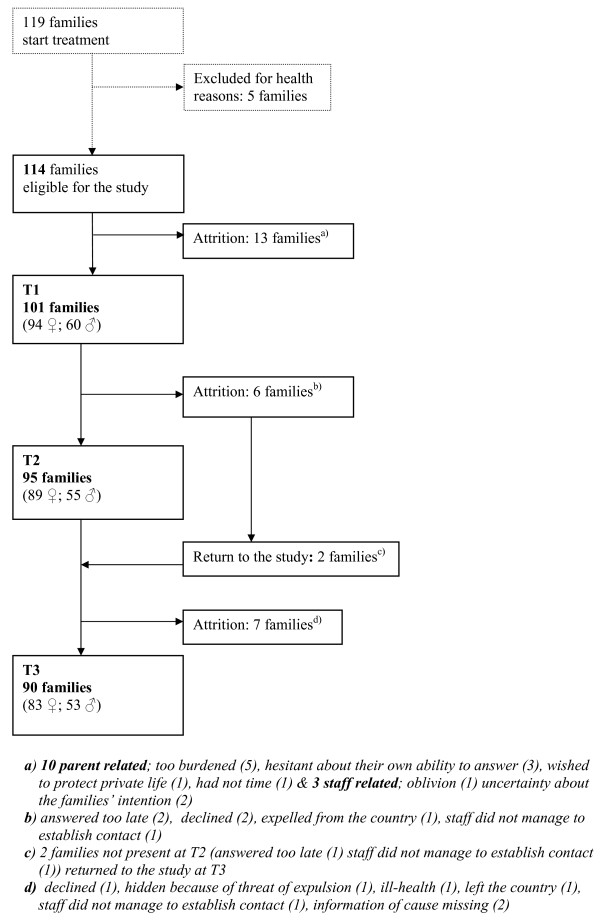
Study flowchart.